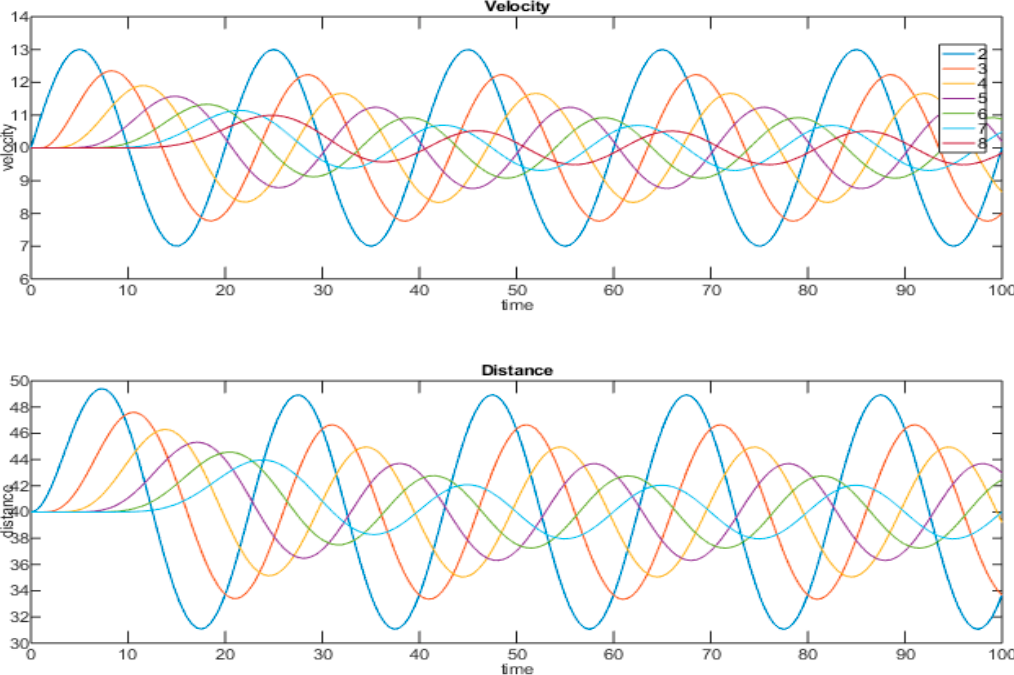
Figure 6. The subplot on ( top ) shows the velocity of the first 7 vehicles that follows the leader, which is subjected to the harmonic perturbation defined in Equation (14). Using the same symbols, the subplot on the ( bottom ) shows the relative distance between a vehicle and the one ahead.